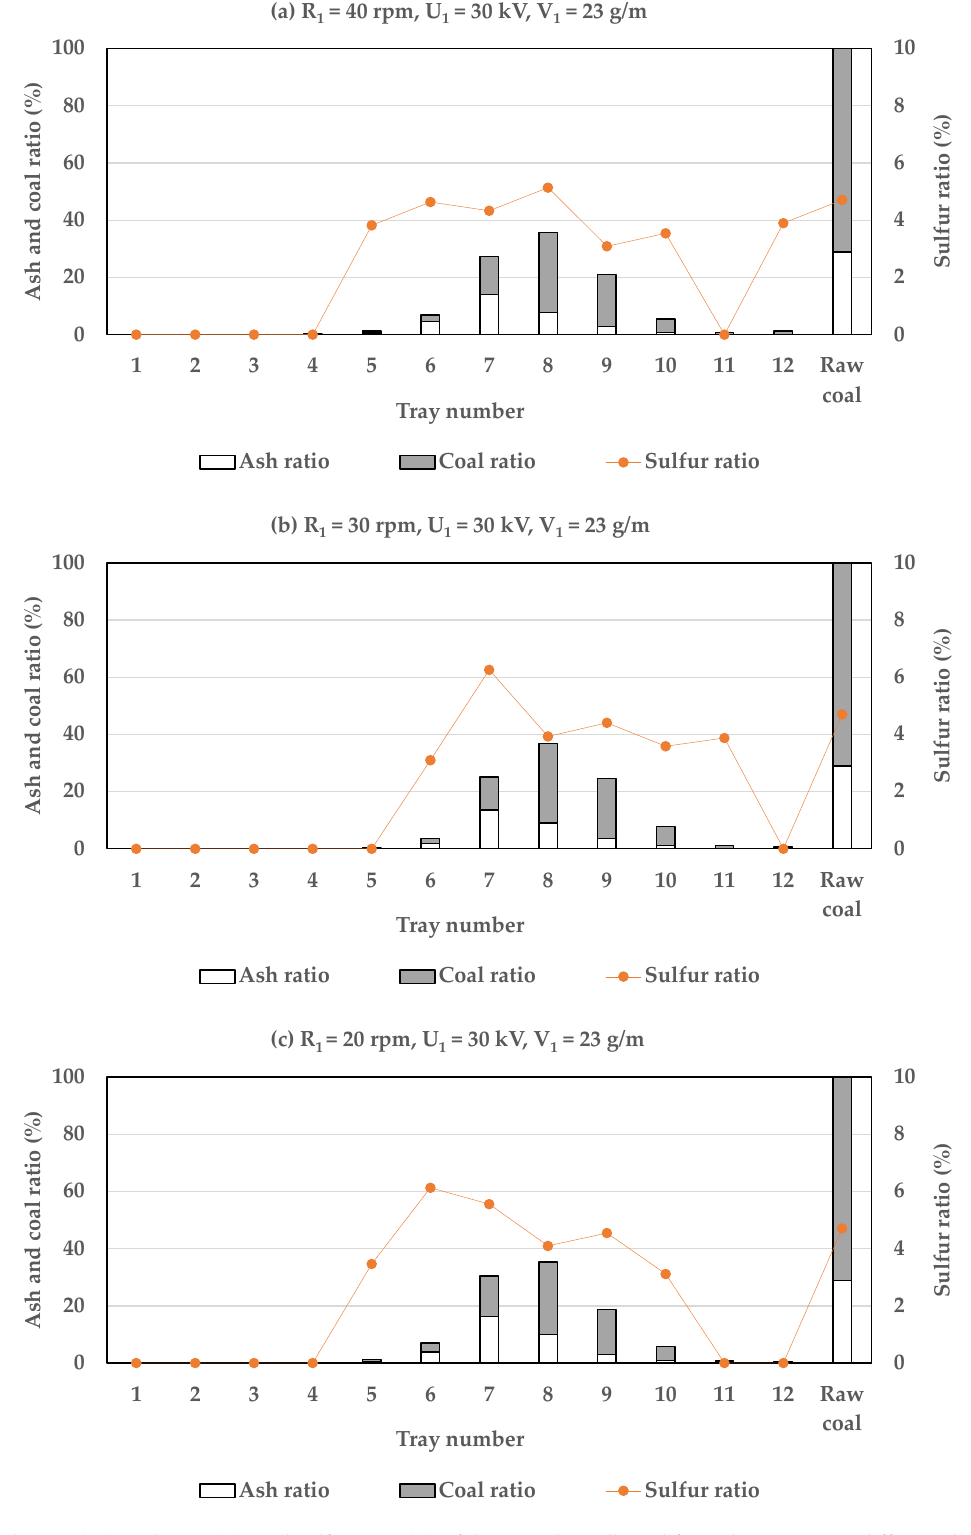
Figure 5. Ash ratio (%), coal ratio (%), and sulfur ratio (%) of the particles collected from the 12 trays at different drum rotational speeds: ( a ) 40 rpm; ( b ) 30 rpm; ( c ) 20 rpm using a dry coal cleaning system with two-stage corona electrostatic processes.